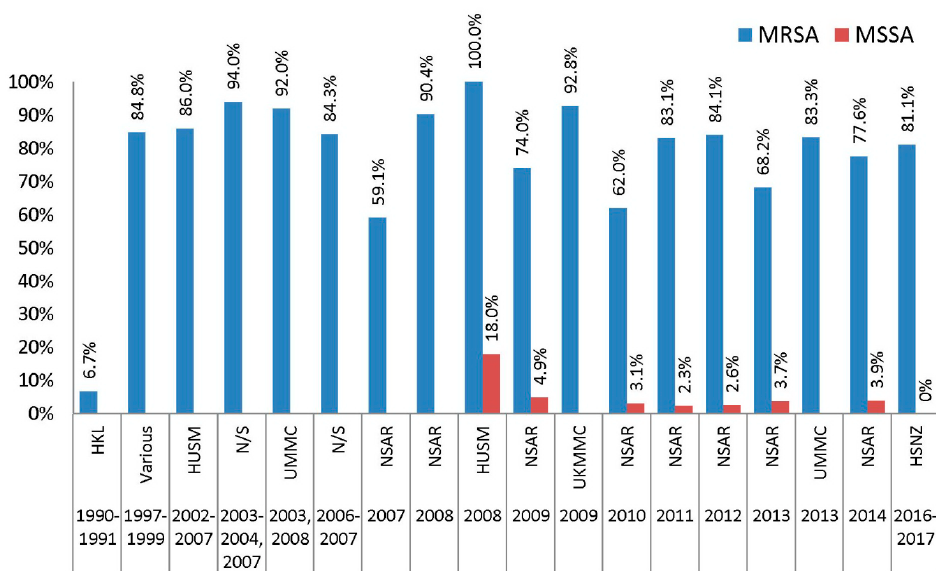
Figure 6. The prevalence of ciprofloxacin resistance among Malaysian S. aureus isolates, 1990–2017. Data from the NSAR reports; HKL between 1990 and 1991 [13]; Various, collected from ten hospitals throughout Malaysia between 1997 and 1999 [14]; HUSM between 2002 and 2007 [15] and in 2008 [19]; not specified (N / S) between 2003 and 2004 and in 2007 [16], and between 2006 and 2007 [17]; UMMC in 2003 and 2008 [18], and 2013 [22]; UKMMC in 2009 [20]; and HSNZ in 2016 and 2017